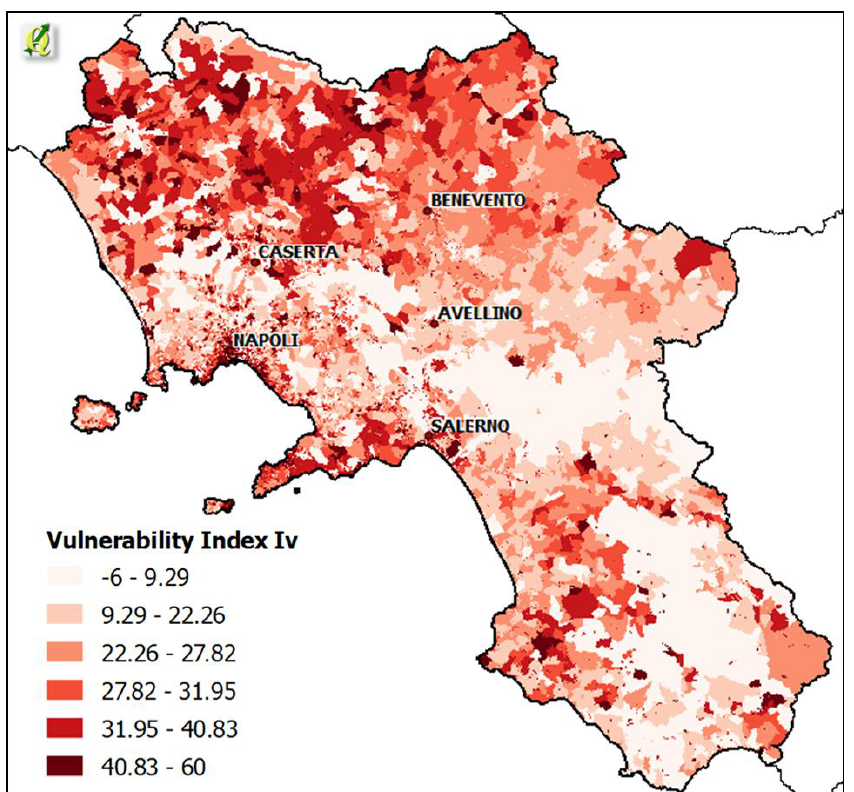
Figure 2. Vulnerability Index Map ( I shown for census